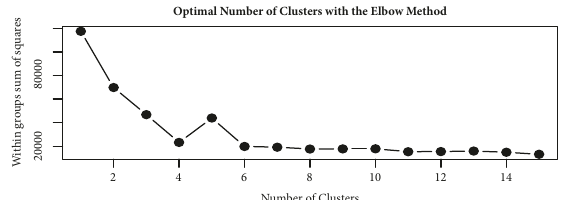
Figure 1: Graph showing four optimal clusters for the Ethiopia dataset.